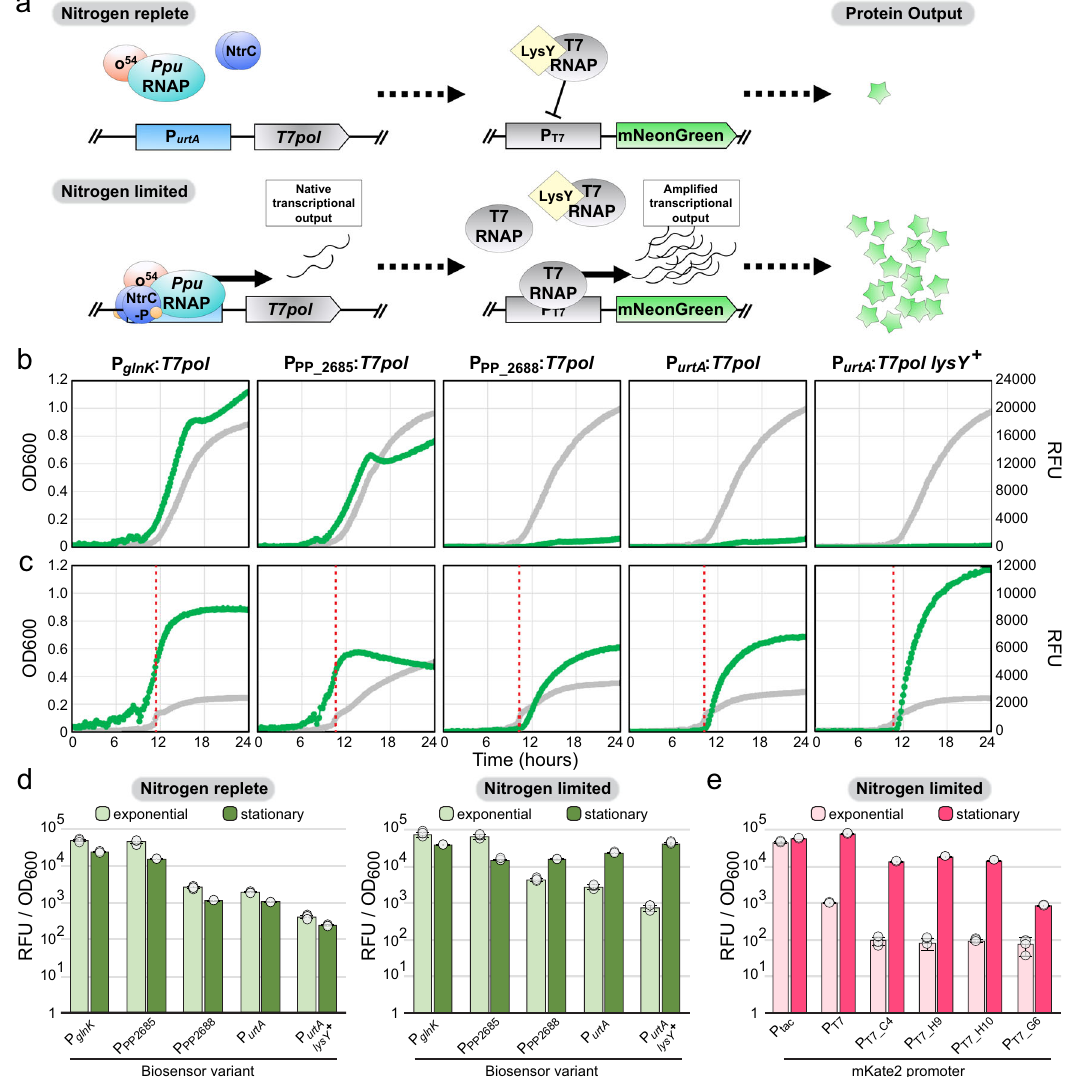
Fig. 3 Development of a nitrogen-limitation biosensor to enable dynamic control of two-stage bioproductions. a Diagram of biosensor design and utilization as a regulated signal ampli fi er for pathway and tool expression. P. putida RNA polymerase (Ppu RNAP), sigma factor 54 ( σ 54), T7 RNA polymerase gene (T7pol), wavy line (mRNA), T7 RNA polymerase protein (T7 RNAP), green stars (mNeonGreen protein). Representative growth curves of triplicate cultures for 96-well microtiter plate cultivations of candidate biosensor strains, biosensor variant indicated, with integrated P T7 :mNeonGreen cassette in either nitrogen-replete ( b ) or nitrogen-limited ( c ) medium. Cell density and mNeonGreen production, as measured by OD600 (gray) and relative fl uorescence units (RFU — green) respectively, were measured every 10 min. Entry to stationary phase is indicated (red dotted line) for nitrogen- limited cultures. d Graph of mNeonGreen production by candidate biosensor sensor strains during exponential growth (light green) or stationary phase (dark green) in microtiter plate cultivations. e Graph of mKate2 production by JE2113-derivatives with integrated P T7 -variant:mKate2 cassettes during exponential growth (light pink) or stationary phase (dark pink) in plate reader cultivations. d, e Data are presented as the mean values ± standard deviation in three replicates. Source data underlying Fig. 3b – e is provided as a Source Data fi